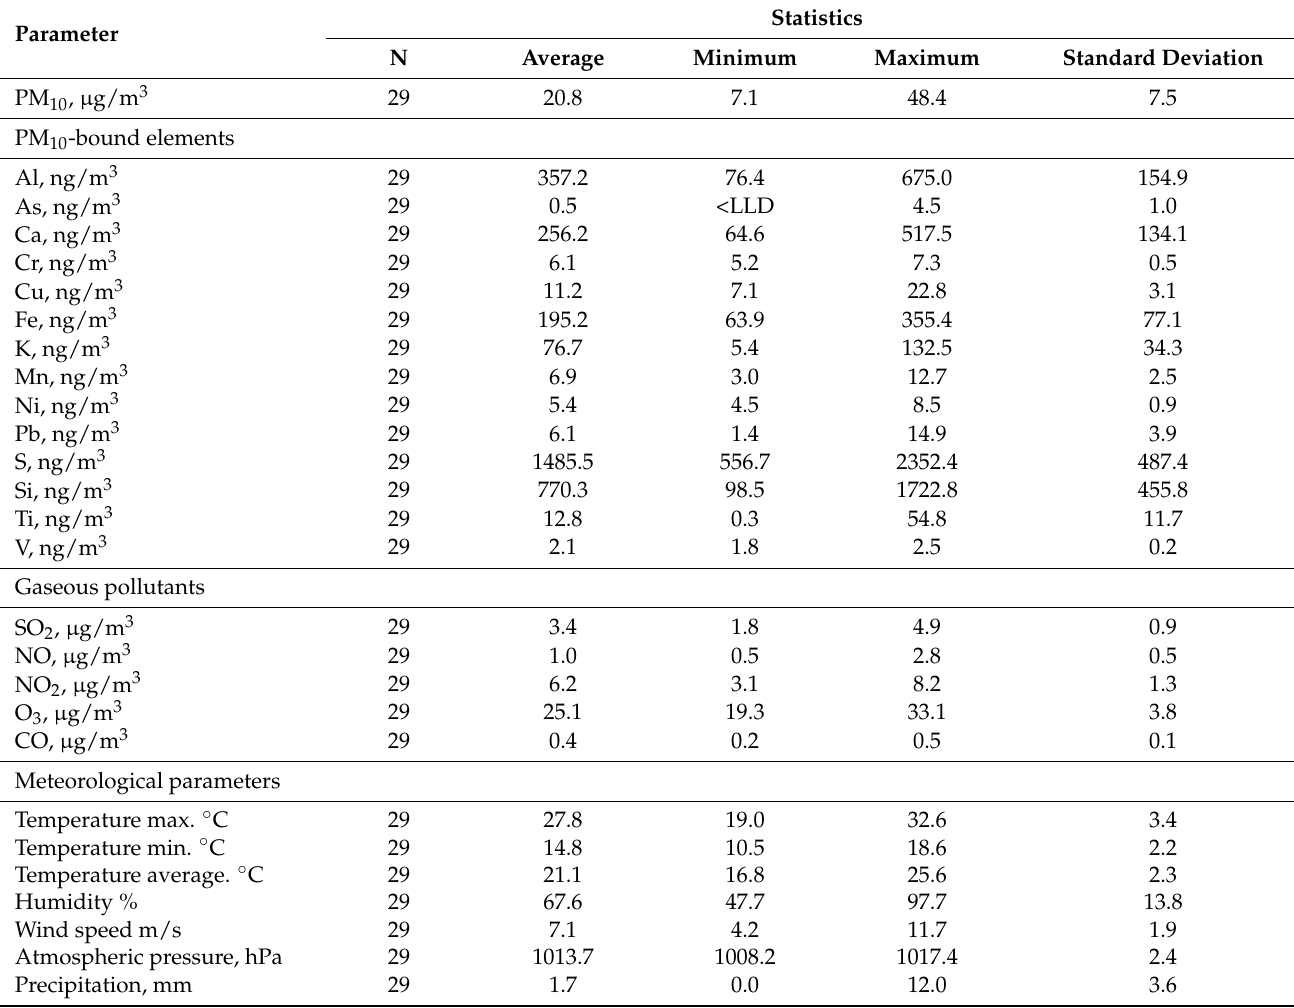
Table 1. Descriptive statistics of a series of 24-h concentrations of PM 10 , PM 10 -bound elements, gaseous pollutants, and meteorological parameters, as measured by the